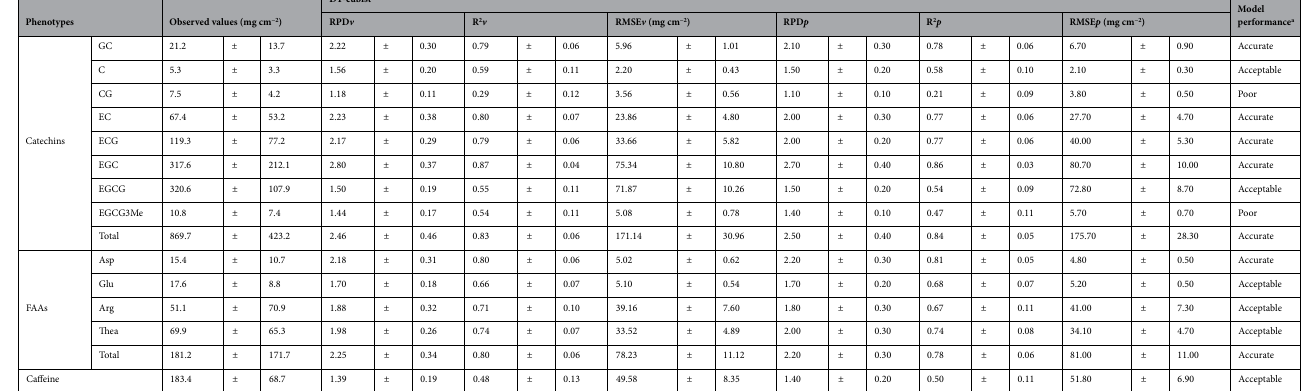
Table 2. Summary of validation and prediction performance based on DT-Cubist in 15 phenotypes for tea quality-related metabolites. “ v ” and “ p ” in each index means validation and prediction, respectively. a Prediction performance is represented as described by Chang et al., (2001); RPD p > 2.0, accurate